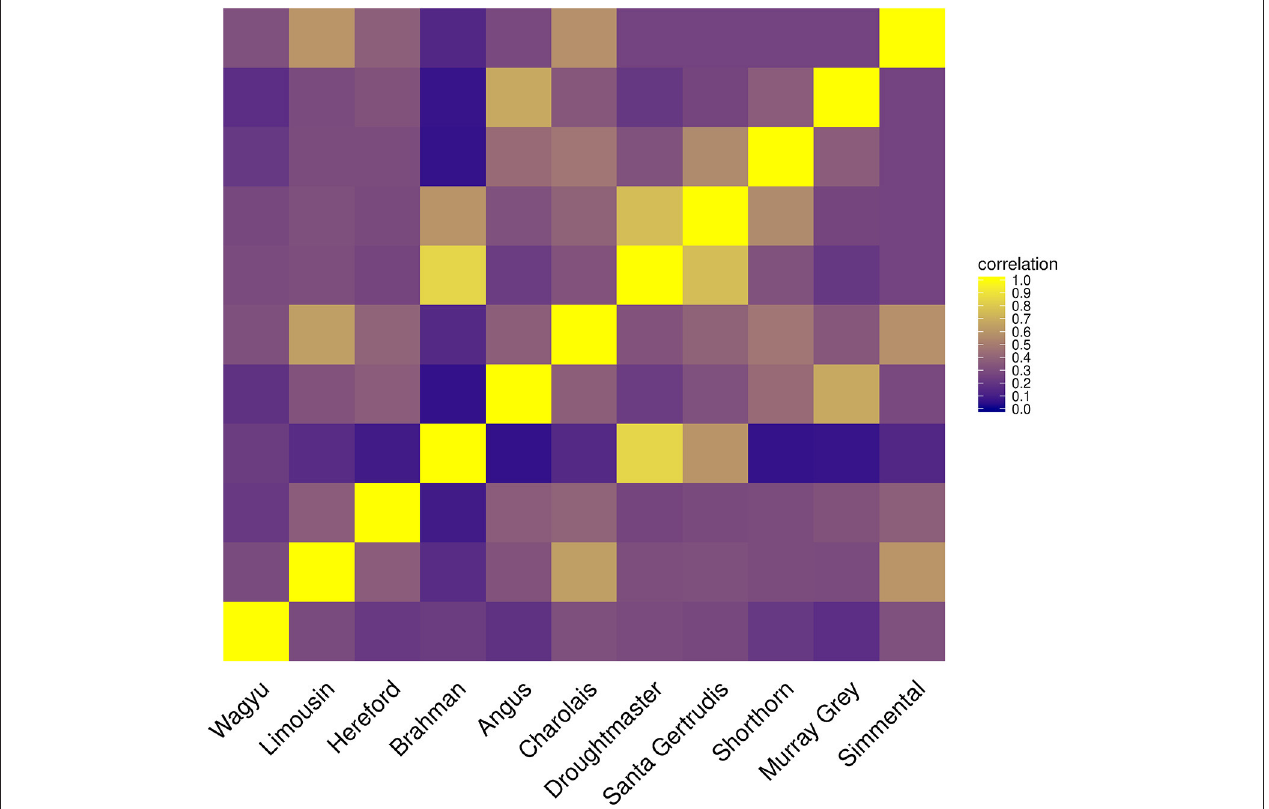
FIGURE 9 | Heatmap of correlations between cattle populations calculated from their allele frequency